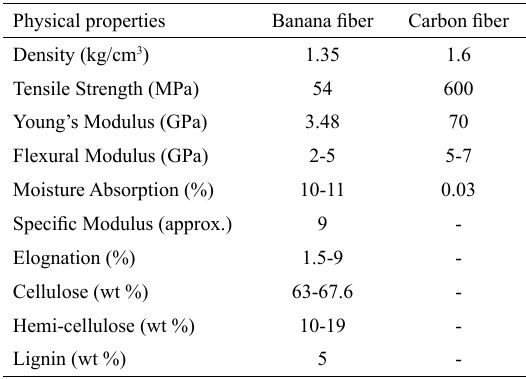
Table 1. Physical properties of banana and carbon fibers